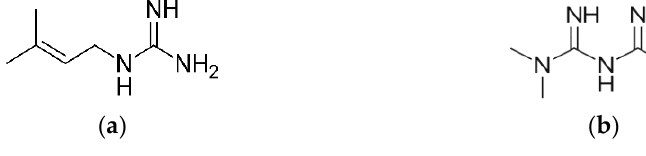
Figure 1. Structures of ( a ) Galegine and ( b ) Metformin.